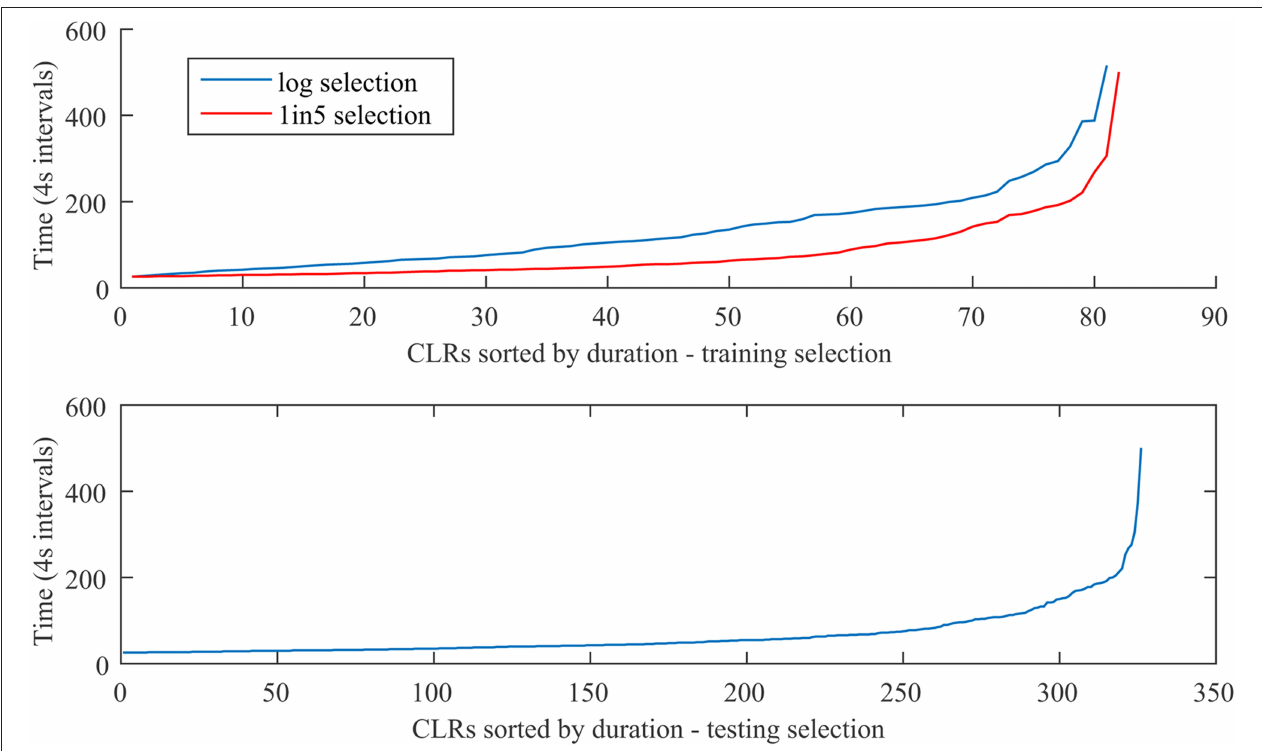
FIGURE 2 | CLRs sorted by duration—training selection (top), testing selection (bottom). The top panel shows both the logarithmic selection (blue) of 81 events and the linear selection (red) 1 out 5, which provides a similar number of events with the logarithmic one. The x axis shows the event index in the respective set, while the y axis shows the event duration in Cluster spin periods of 4s (the number on y axis should be multiplied by four to get the duration in seconds). See text for details.